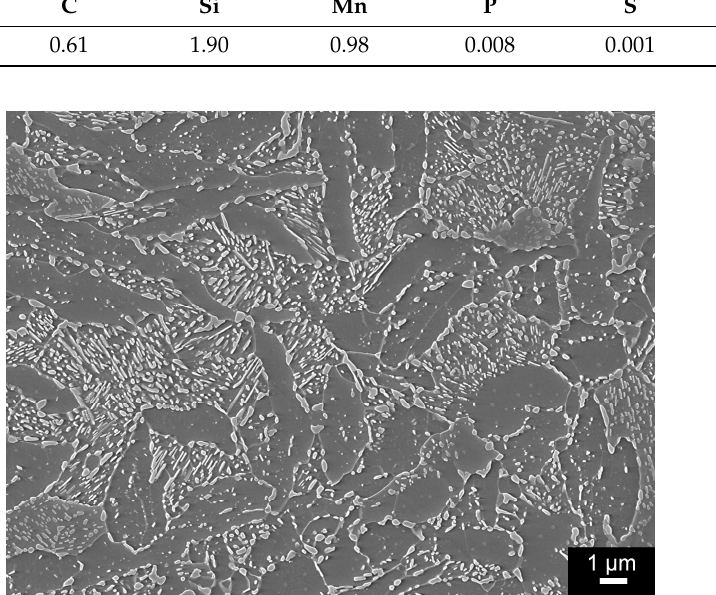
Figure 2. Initial microstructure of the current sample (secondary electron image, acceleration voltage: 15.0 kV, working distance: 15.0 mm). The horizontal and vertical directions are the RD and ND in the hot-rolling process, respectively.